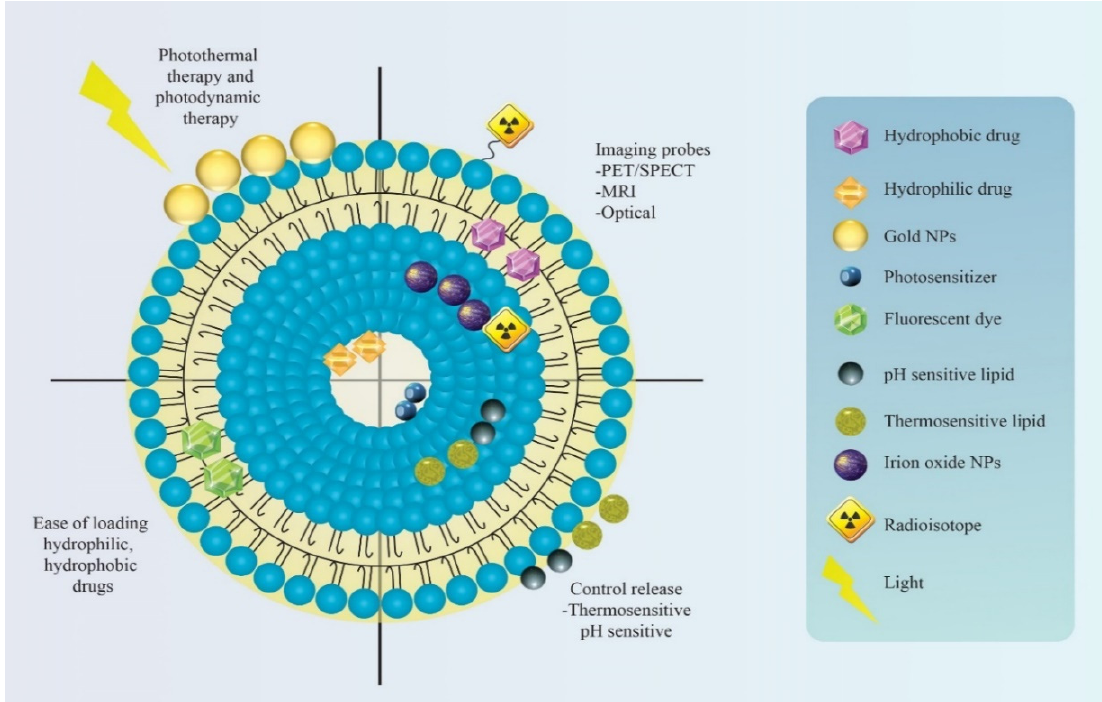
Figure 2. Brief depiction of how lipidic theranostic can help in cancer alleviation via multi-functionalized aspects such as coupling of the imaging probe, surface with gold nanoparticles for photothermal therapy.